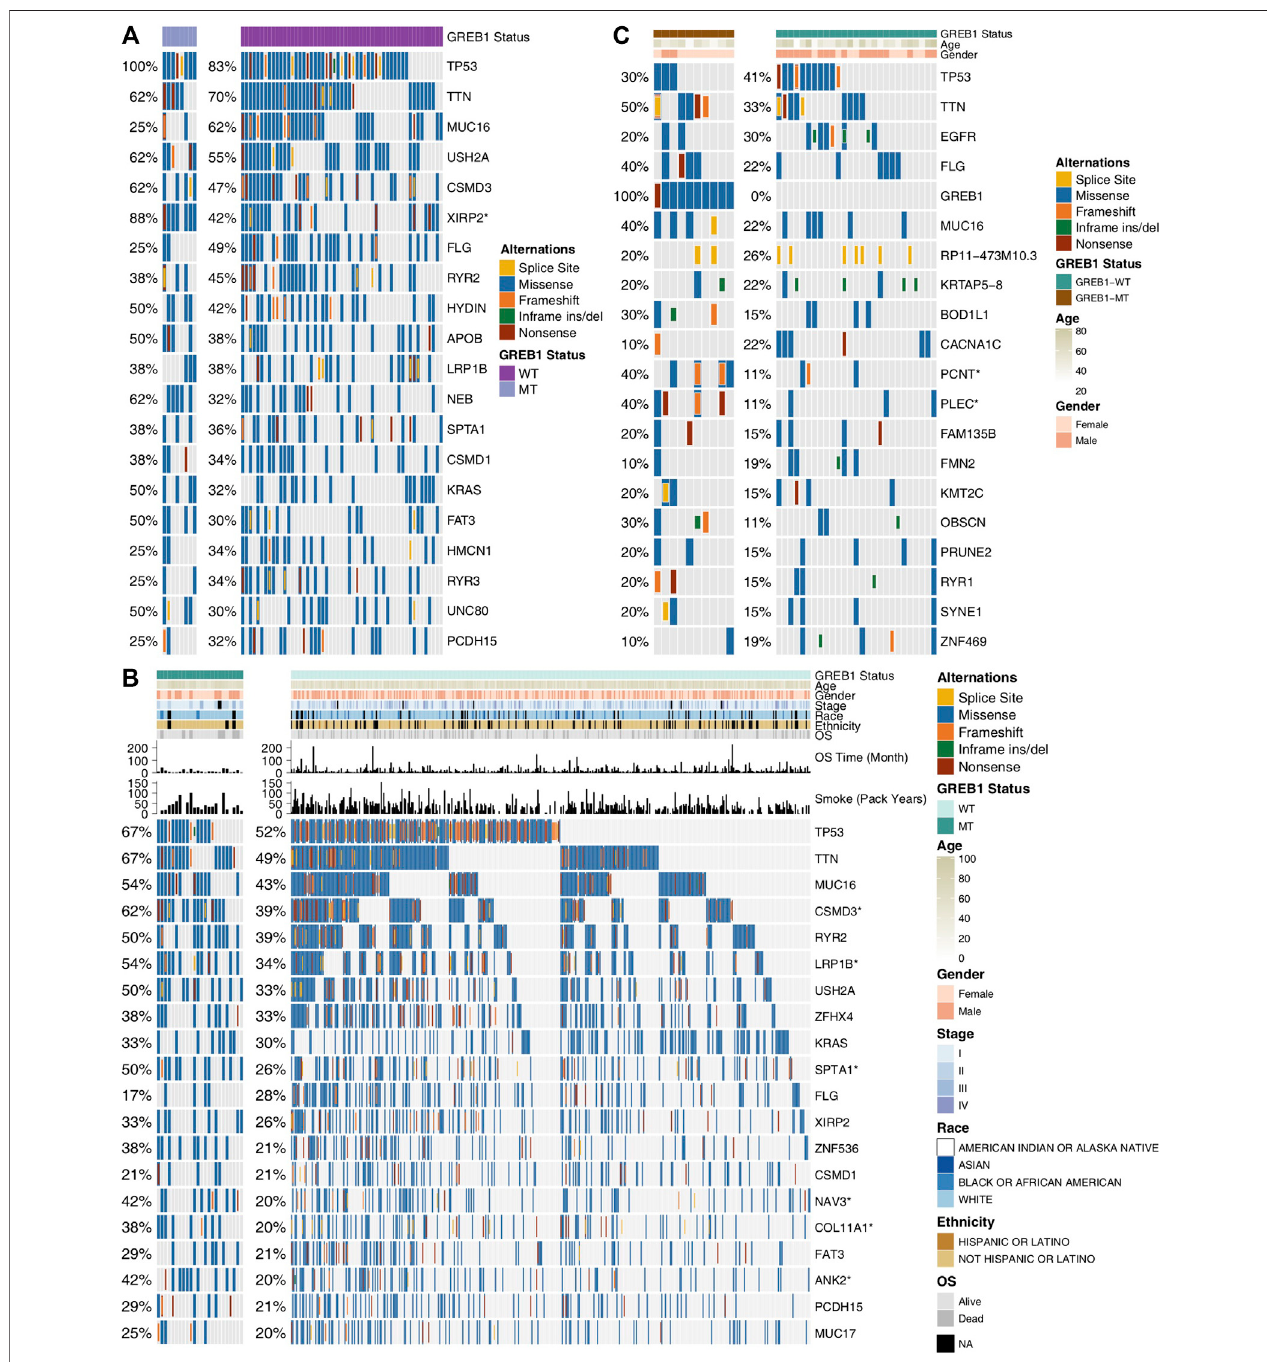
FIGURE3| GenomicalterationsinLUAD. (A) Sixty-oneLUADcelllinesarearrangedaccordingtotheirGREB1mutationstatus,fromleft(withGREB1mutations)to right(withoutGREB1mutations).GenealterationsintheLUADcelllineareannotatedforeachsampleaccordingtothecolorpanelbelowtheimage.Tumorsamplesfrom TCGA-LUAD (B) and Local-LUAD (C) are arranged according to their GREB1 mutation status, from left (with GREB1 mutations) to right (without GREB1 mutations). Alterations in TCGA-LUAD candidate genes are annotated for each sample according to the color panel below the image. Clinical information for each candidate gene isplotted inthe top panel. **** p < 0.0001;*** p < 0.001; ** p < 0.01; * p < 0.05 (Fisher ’ sexact test). LUAD, lung adenocarcinoma; TCGA, The Cancer Genome Atlas.